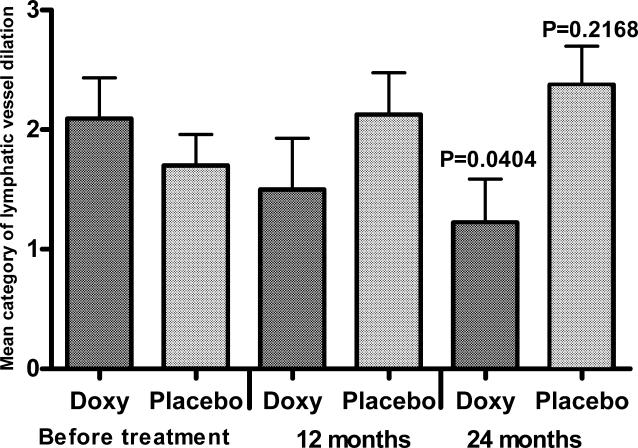
The Effect of Doxycycline Treatment on the Supratesticular Lymphatic Vessel Dilation at Various Time PointsThe supratesticular lymphatic vessel dilation (mean of category ± SD) was determined before treatment, and 12 and 24 mo thereafter, using USG. The mean supratesticular lymphatic vessel dilation of doxycycline-treated (Doxy) patients improved significantly compared to pretreatment (n = 9, p = 0.0404) at 24 mo, in contrast to the placebo group (n = 8) (paired t-test).